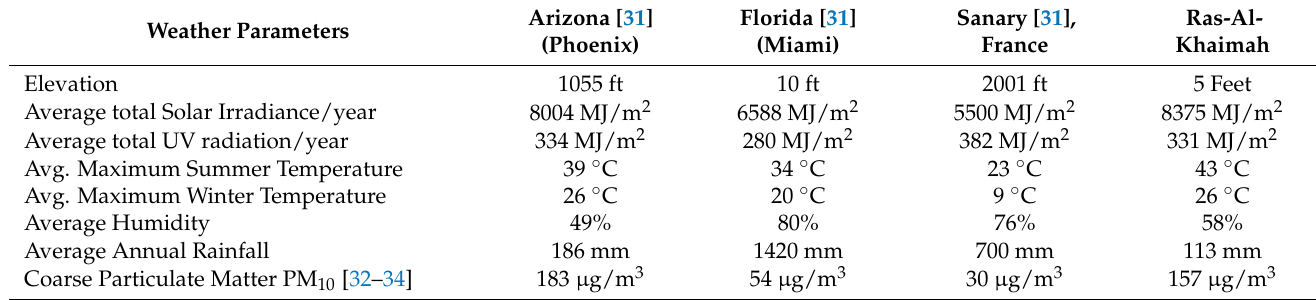
Table 2. Weather parameters of RAK test site compared with benchmark